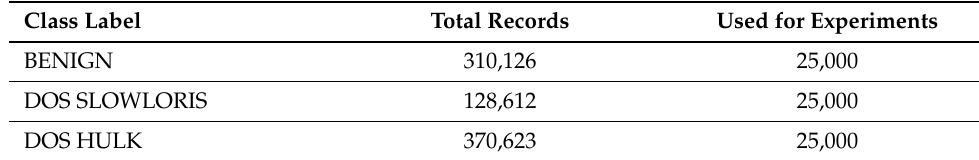
Table 3. Number of samples corresponding to each class.